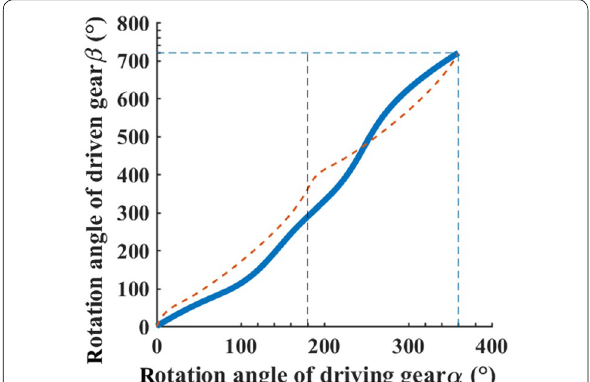
Figure 4 Rotation-angle curves of the symmetrical and asymmetrical second-order non-circular gear trains